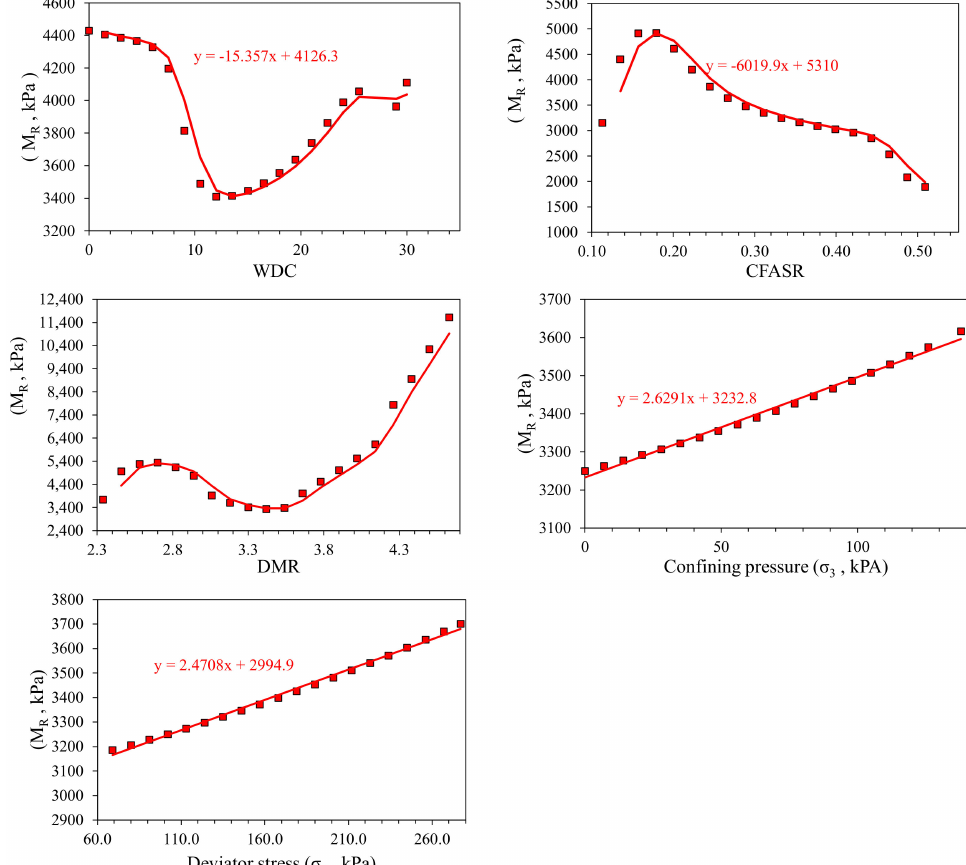
Figure 6. Parametric study of the ANN